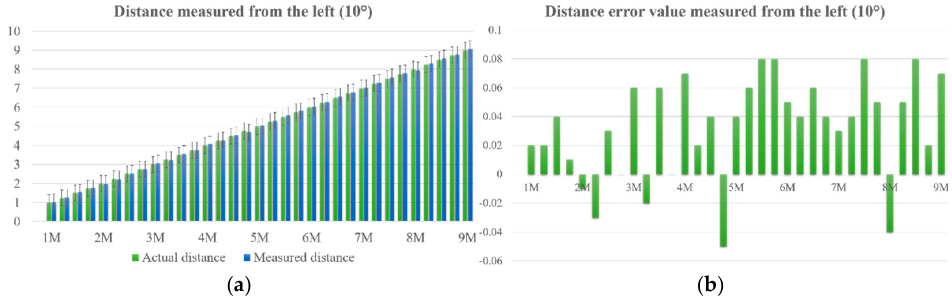
Figure 7. ( a ) Distance measured from the left (10°), ( b ) distance error value measured from the left (10°).